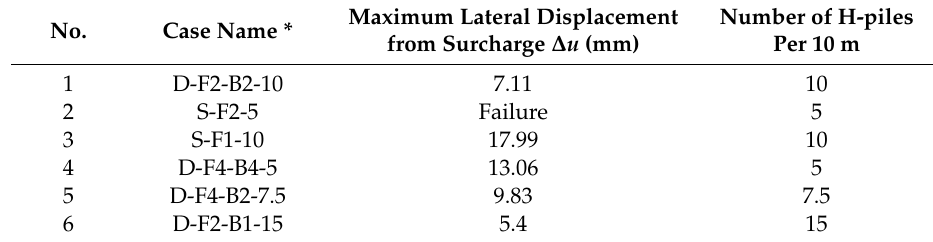
Table 2. Lateral displacement from a surcharge based on numerical analysis [10].